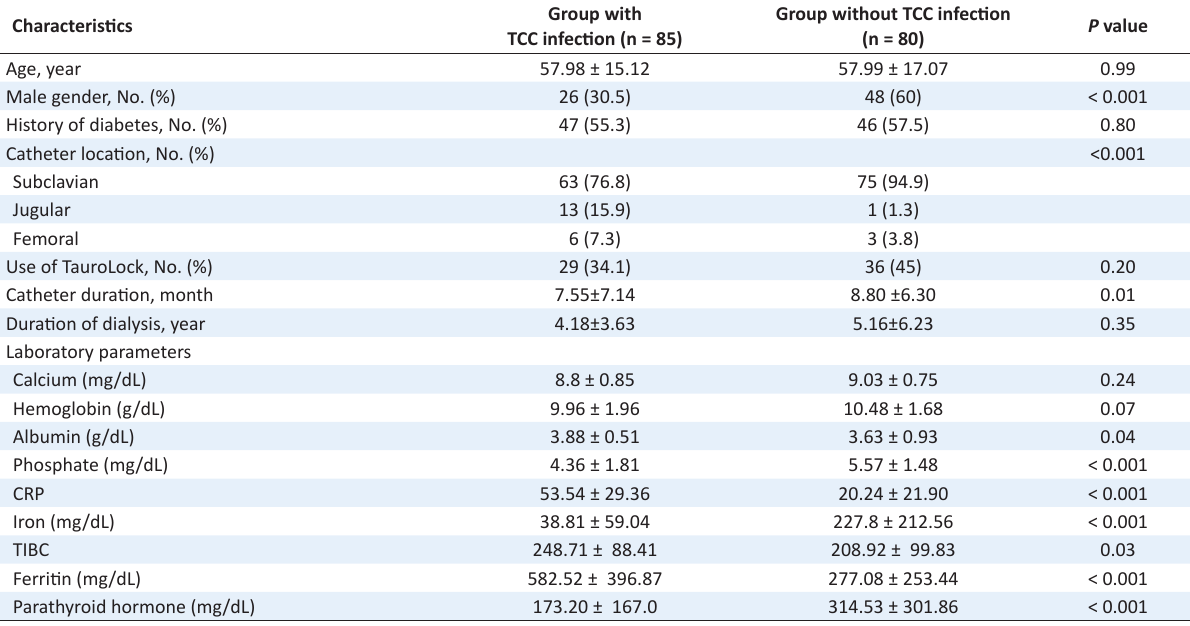
Table 1. The baseline characteristics and clinical data in groups with and without TCC infection